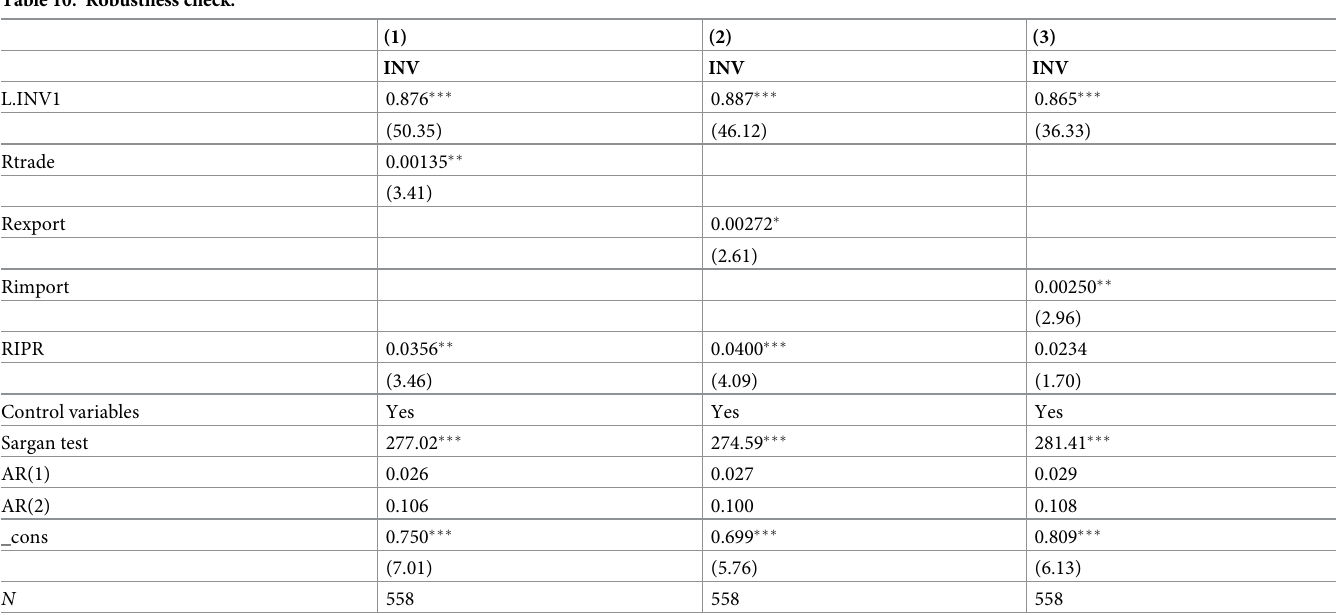
Table 10. Robustness check.